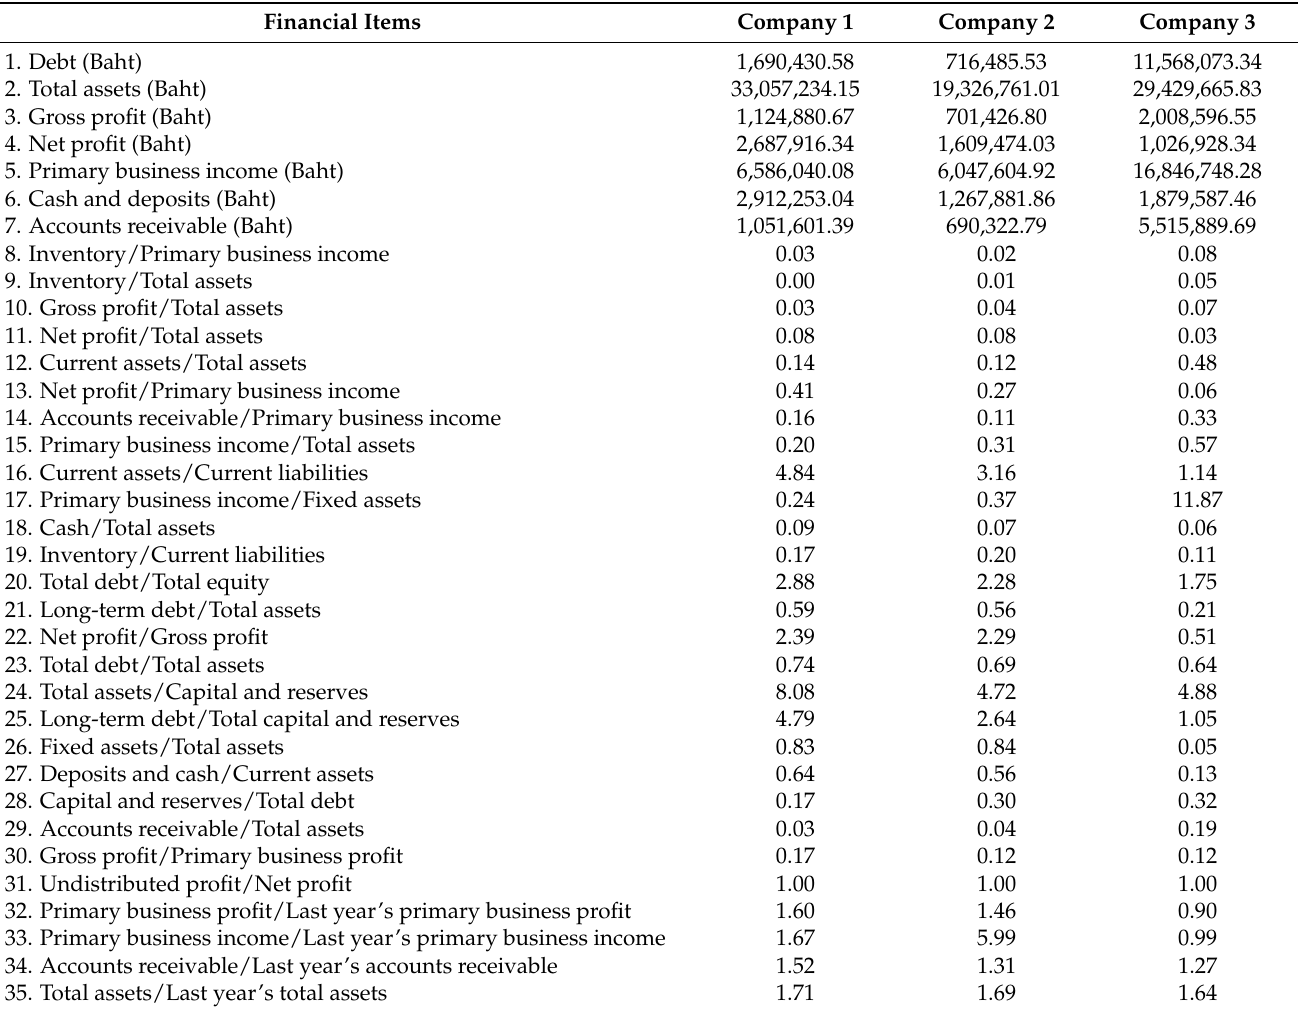
Table 2. Examples of financial items from three